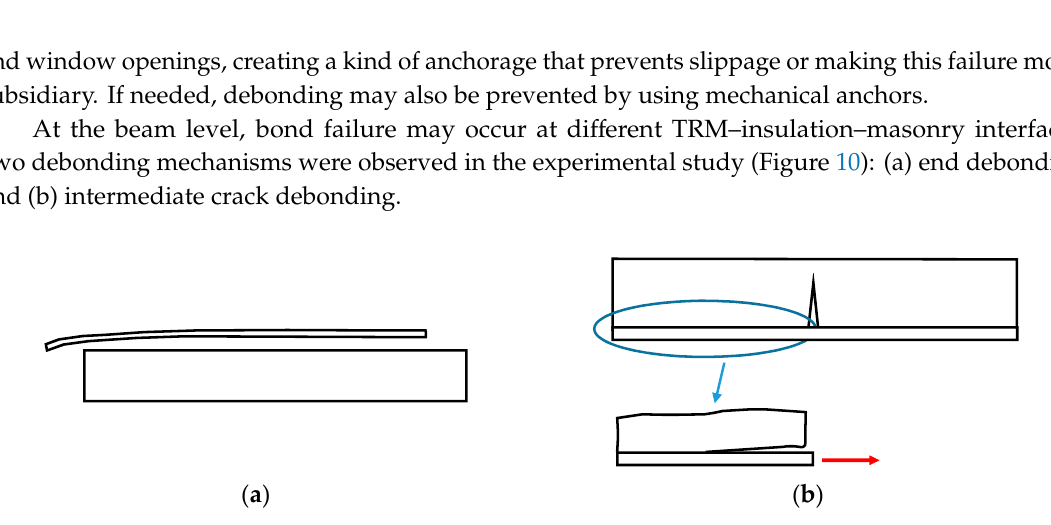
Figure 10. Debonding mechanisms: ( a ) end debonding, ( b ) intermediate crack debonding.